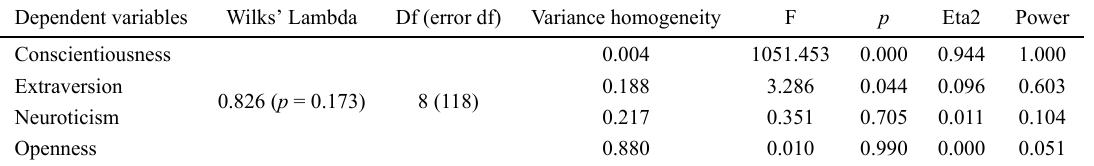
Table 5. Multivariate analysis of variance results of personality factor by sports type.